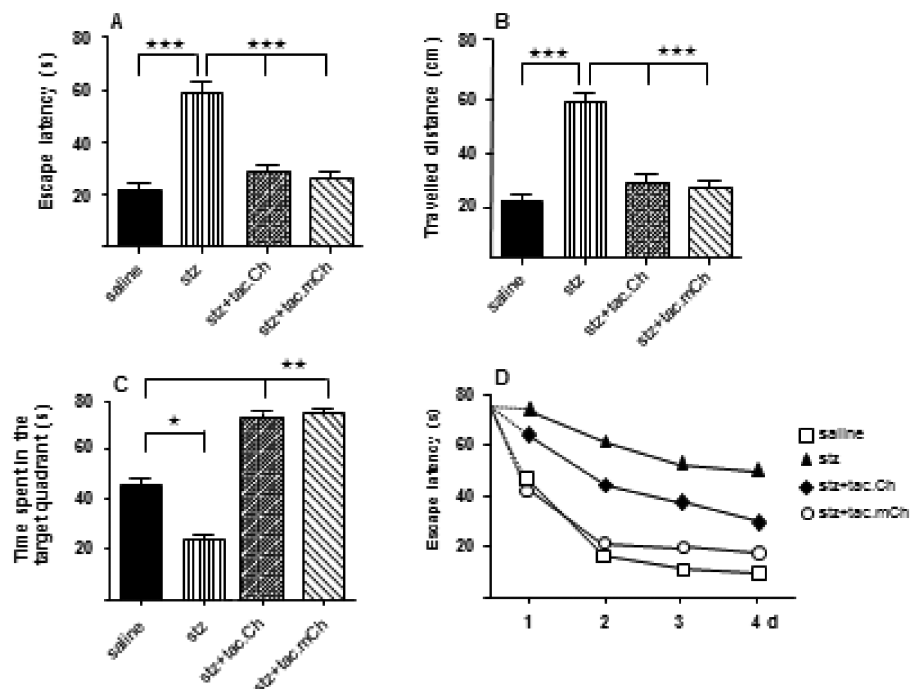
Figure 1. Effect of treatment on behavioral performance. (A) Escape latency and (B) travelled distance both after 4d, (C) time spent in the target quadrant after 4d, (D) escape latency during 4d training period. Stz increased escape latency and travelled distance compared to saline control animals (***p≤0.0001 stz vs saline). These effects were antagonized by the co-application of tac+Ch and tac+mCh at equal levels (***p≤0.0001). In contrast, stz reduced the time spent in the target quadrant (*p≤0.01 stz vs saline). Again, this effect was abolished by either of the two above treatment groups. Moreover, all two groups show increased levels compared to the saline group (**p≤0.001). Time course of escape latency experiments expressed from an individual animal per group (D) reveals that in all groups a reduction can be observed during the training period with worst improvement in the stz group and equal learning improvement in the mCH and saline group. The initial slope of acquisition was much faster in the saline and mCh